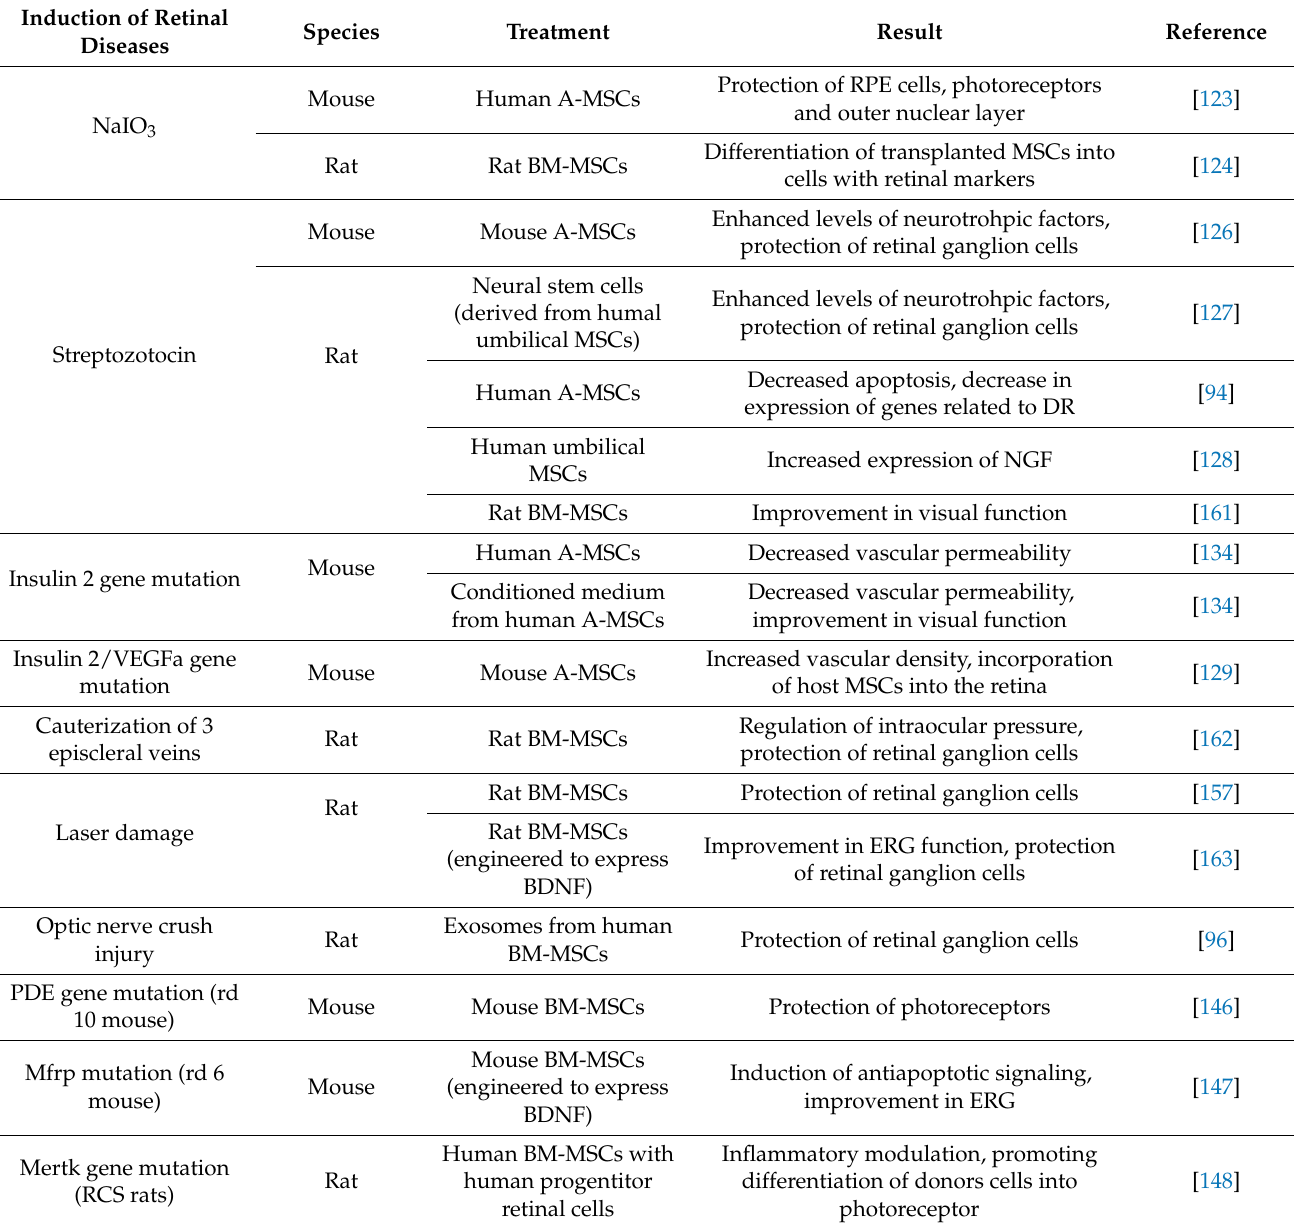
Table 1. Selected experimental models of MSC-based therapy for retinal degenerative